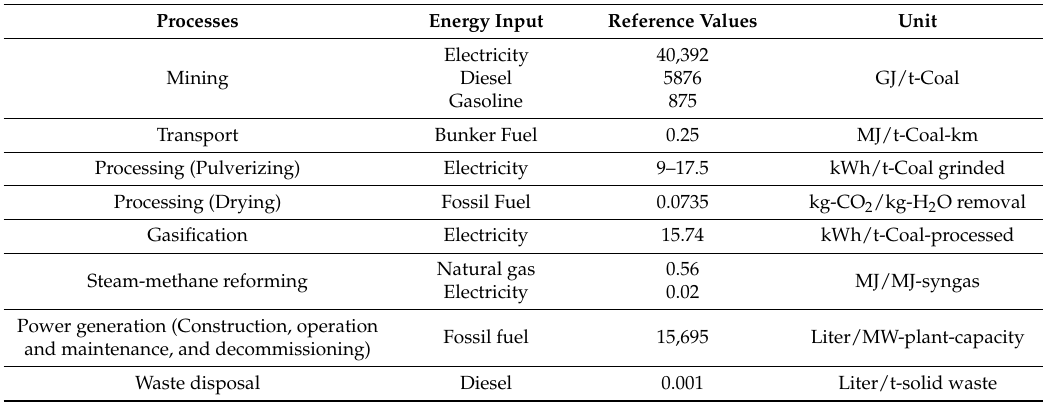
Table 7. Key assumptions on the operating parameters of the IGCC